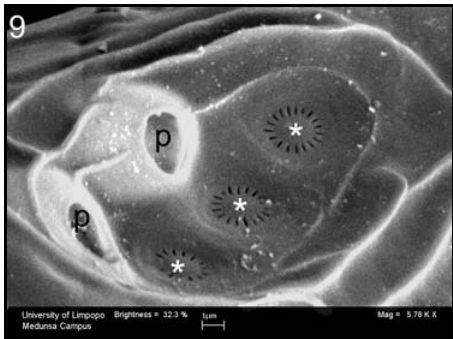
Fig. 9. The 2 pore organs (p) with three plate organs showing the characteristic radiating pattern of slit- like